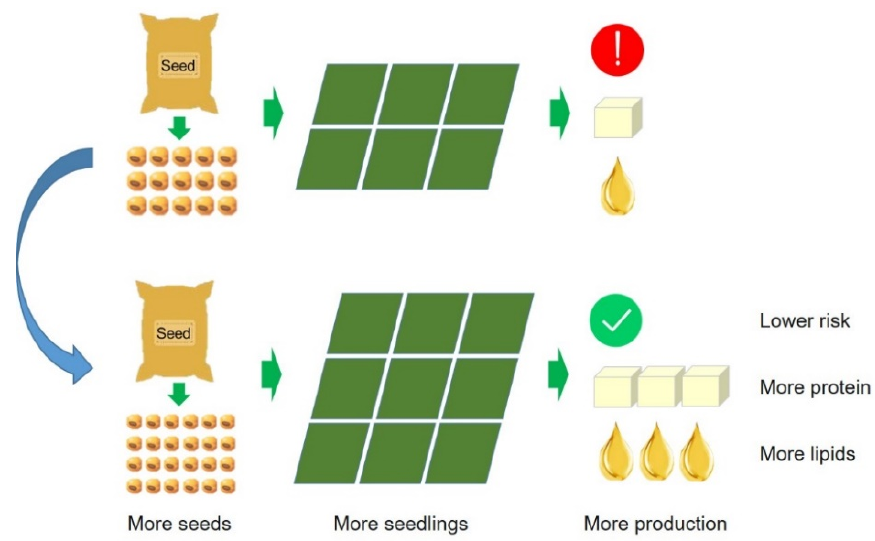
Figure 9. Soybean cultivars with smaller seed sizes can produce more protein and lipids.